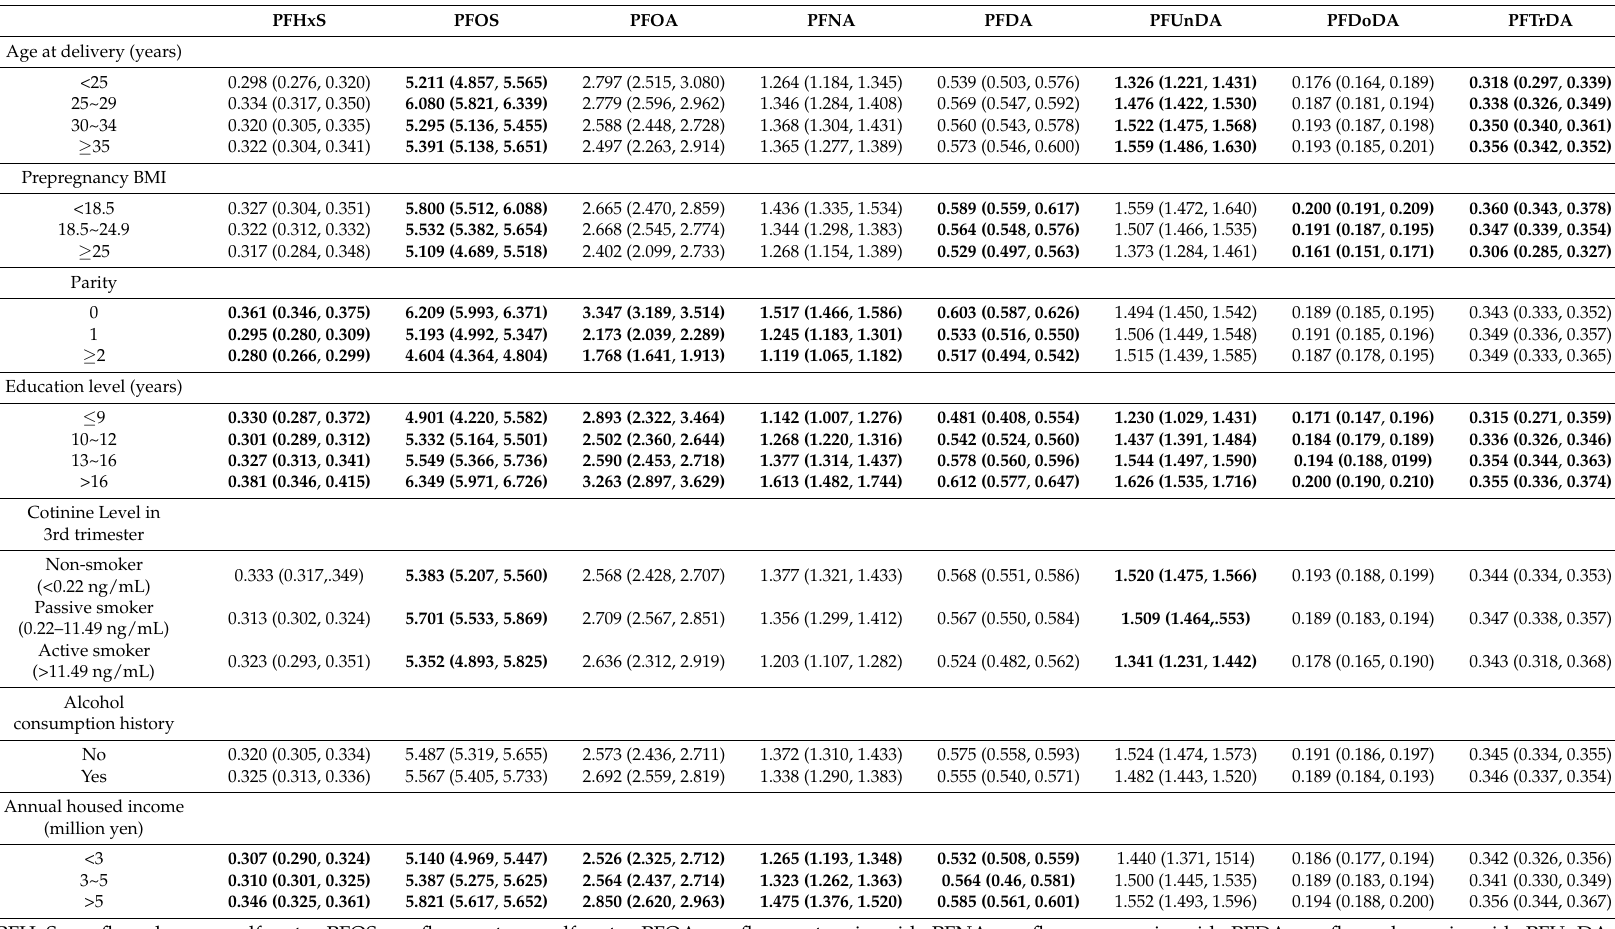
Table 3. Mean value and 95% confidence intervals of PFAS concentration in each characteristic on pregnant women a